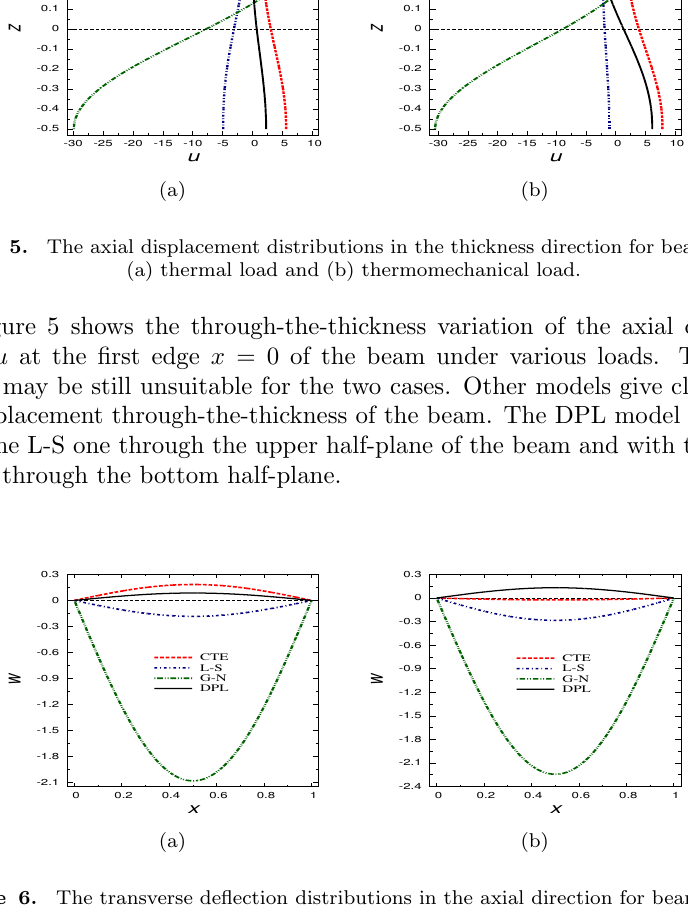
Figure 6. The transverse deflection distributions in the axial direction for beams under (a) thermal load and (b) thermomechanical load. Figure 6 shows the variation of the transverse displacement w along the axial direction at the middle surface z = 0. Each model gives different behavior of w along the axial direction of the beam. The maximum (minimum) deflection occurs at the center of the beam for the CTE and DPL models (G-N and L-S models) in the first case. However, the maximum deflection occurs